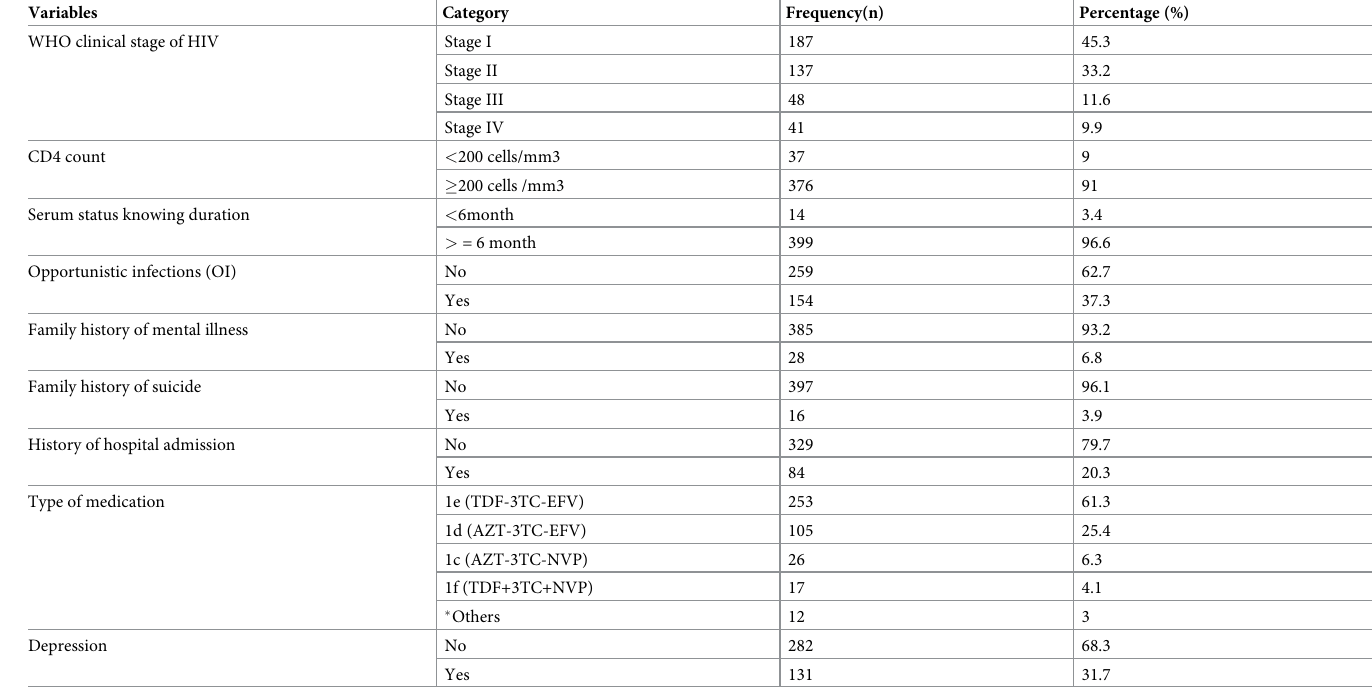
Table 2. Clinical factors of HIV positive youth follow up at SPSH and SPHMMC Addis Ababa, Ethiopia, 2018 (n = 413).